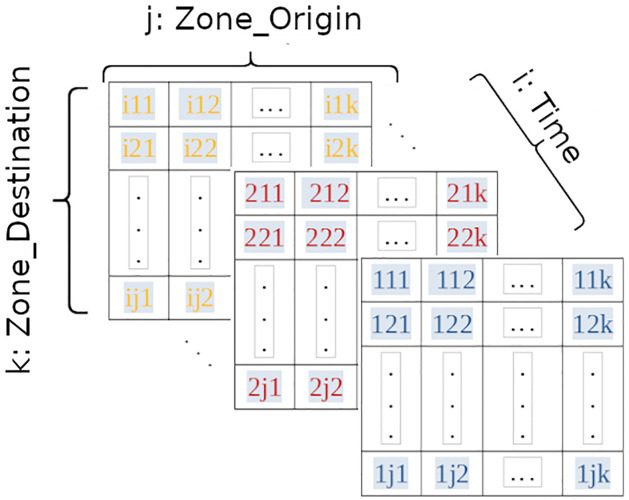
3-dimension matrix.